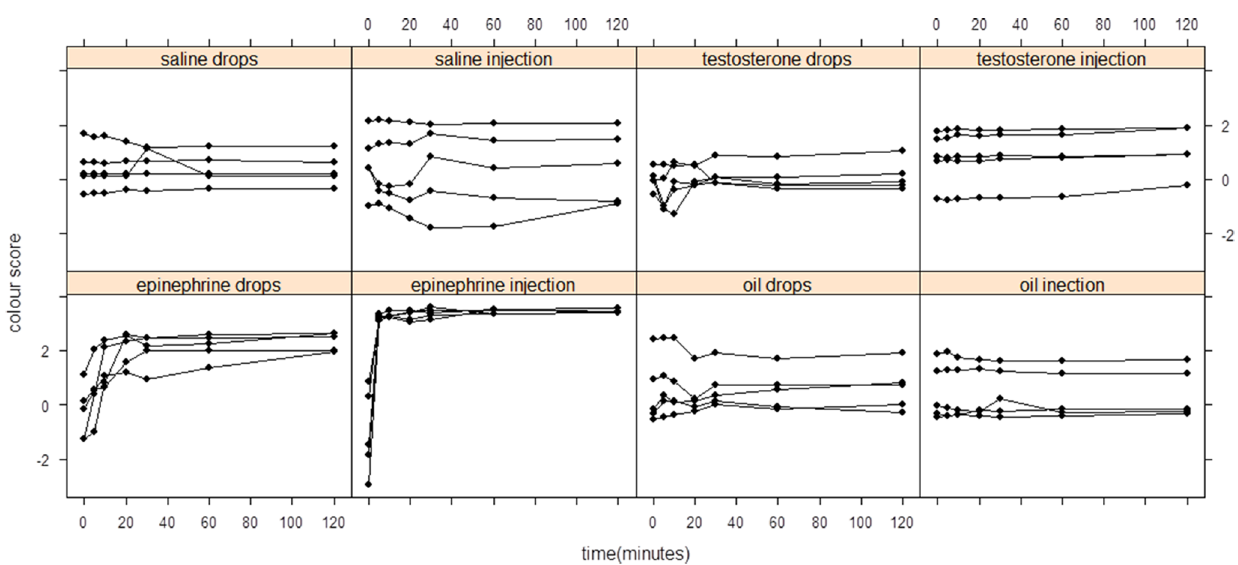
Figure 3. Colour change in L . wilcoxii in response to control and hormone treatments (n 5 5 individual frogs per group). Each point indicates the dorsal colour of a frog at each time point (0–120